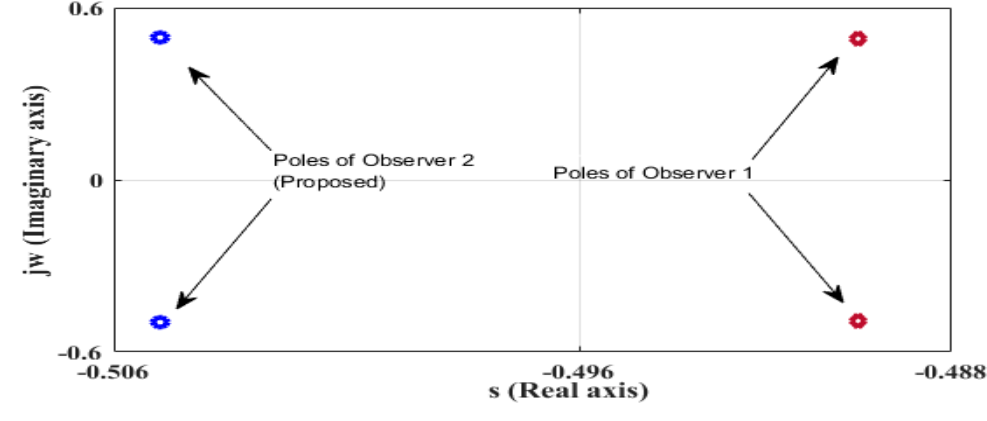
Figure 25. Pole placement of SMLO 1 and SMLO 2.